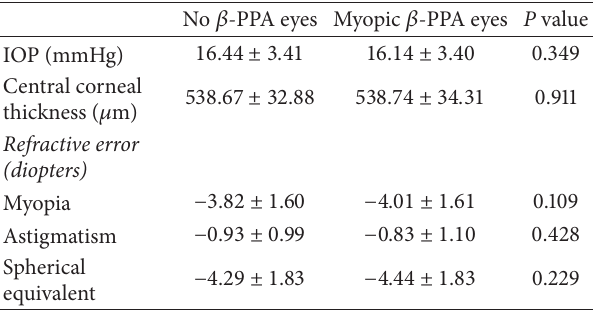
Table 1: Demographics and baseline clinical characteristics of the study